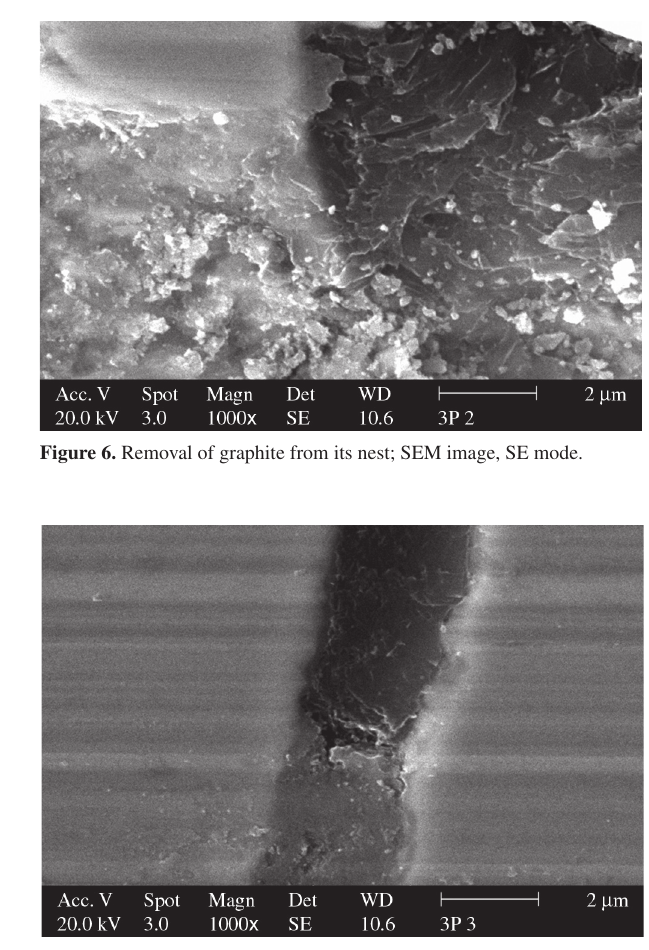
Figure 7. Partially empty nest after the last phase of graphite removal; SEM image; SE